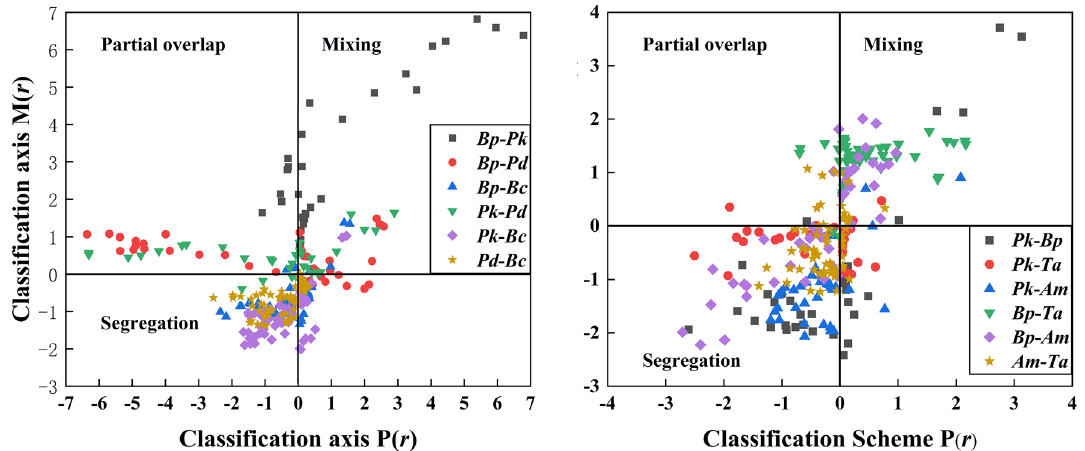
Figure 4. Species association classification using the Wiegand scheme in both disturbed (left) and undisturbed (right) Species mingling and neighborhood comparison index. The average mingling indexes varied from 0.5124 to 0.7671 and 0.3425 to 0.8202, respectively. In the disturbed plot, weak, middle and strong mingling could be observed in species Bp . while the frequencies of the mingling index in species Pk , Pd and Bc showed an increasing trend in the disturbed plot. In the undisturbed plot, the species Bp , Am and Ta showed a high level of mixing, especially the mingling index of Ta was more distributed in 0.75 and 1.00 values. The species Pk was dis- tributed in all values of the degree of mingling indexes, but the degree of weak and middle mingling was higher than the degree of strong and extremely strong. The frequency of neighborhood comparison index distributed ranges from 0.3475 to 0.6951 and 0.4374 to 0.6443 in both disturbed and undisturbed plots (Fig. 2). In the disturbed plot, the neighborhood comparison index of Bp was mainly distributed in the values of 0.00, 0.25, and 0.5, and these values explained that the diameters with more than 80% target trees were larger than those of neighbor trees, which was in the absolute dominant position. Frequency distributions of Pk and Bc mainly focused on the values of 0.5, 0.75 and 1.00, which explained that these two species existed smaller than neighbors. The species Pd distributed evenly among all the values, and the average neighborhood comparison index was closed to 0.5 (0.4800). Pk was the chief species in the undisturbed plot, but the degree of dominance (frequency in the value 0.00) was inconspicuous. The average neighborhood comparison index of Bp trees was closed to 0.5 (0.5093), which was in the moderate position. The frequencies of an index in Am and Ta was mainly distributed in the values of 0.75 and 1.00, which explained that these two species existed smaller trees than neighbors. However, these trends changed slowly in this plot (Fig. 2). Species associations and classification scheme. In the disturbed plot, Bp was positive correlated to Pk at scales ≤ 5 m and 19–21 m, tendencies towards segregation emerged at another scale. However, Bp and Pd trees showed significant aggregation at 8–30 m scales. On the contrary, Bc trees were negatively associated with Bp and Pk trees at larger scales. The trends of positive associations between Pk - Pd and Pd - Bc species pairs increased with scales, but species pairs of Pd - Bc showed negative association at scales ≤ 12 m. In the undisturbed plot, segrega- tion trend of species pair of Pk and Bp was observed at ≤ 13 m scales, and when the scales increased, independent and positive associations emerged. In almost all scales, Pk and Am trees exhibited spatial independence. Trees